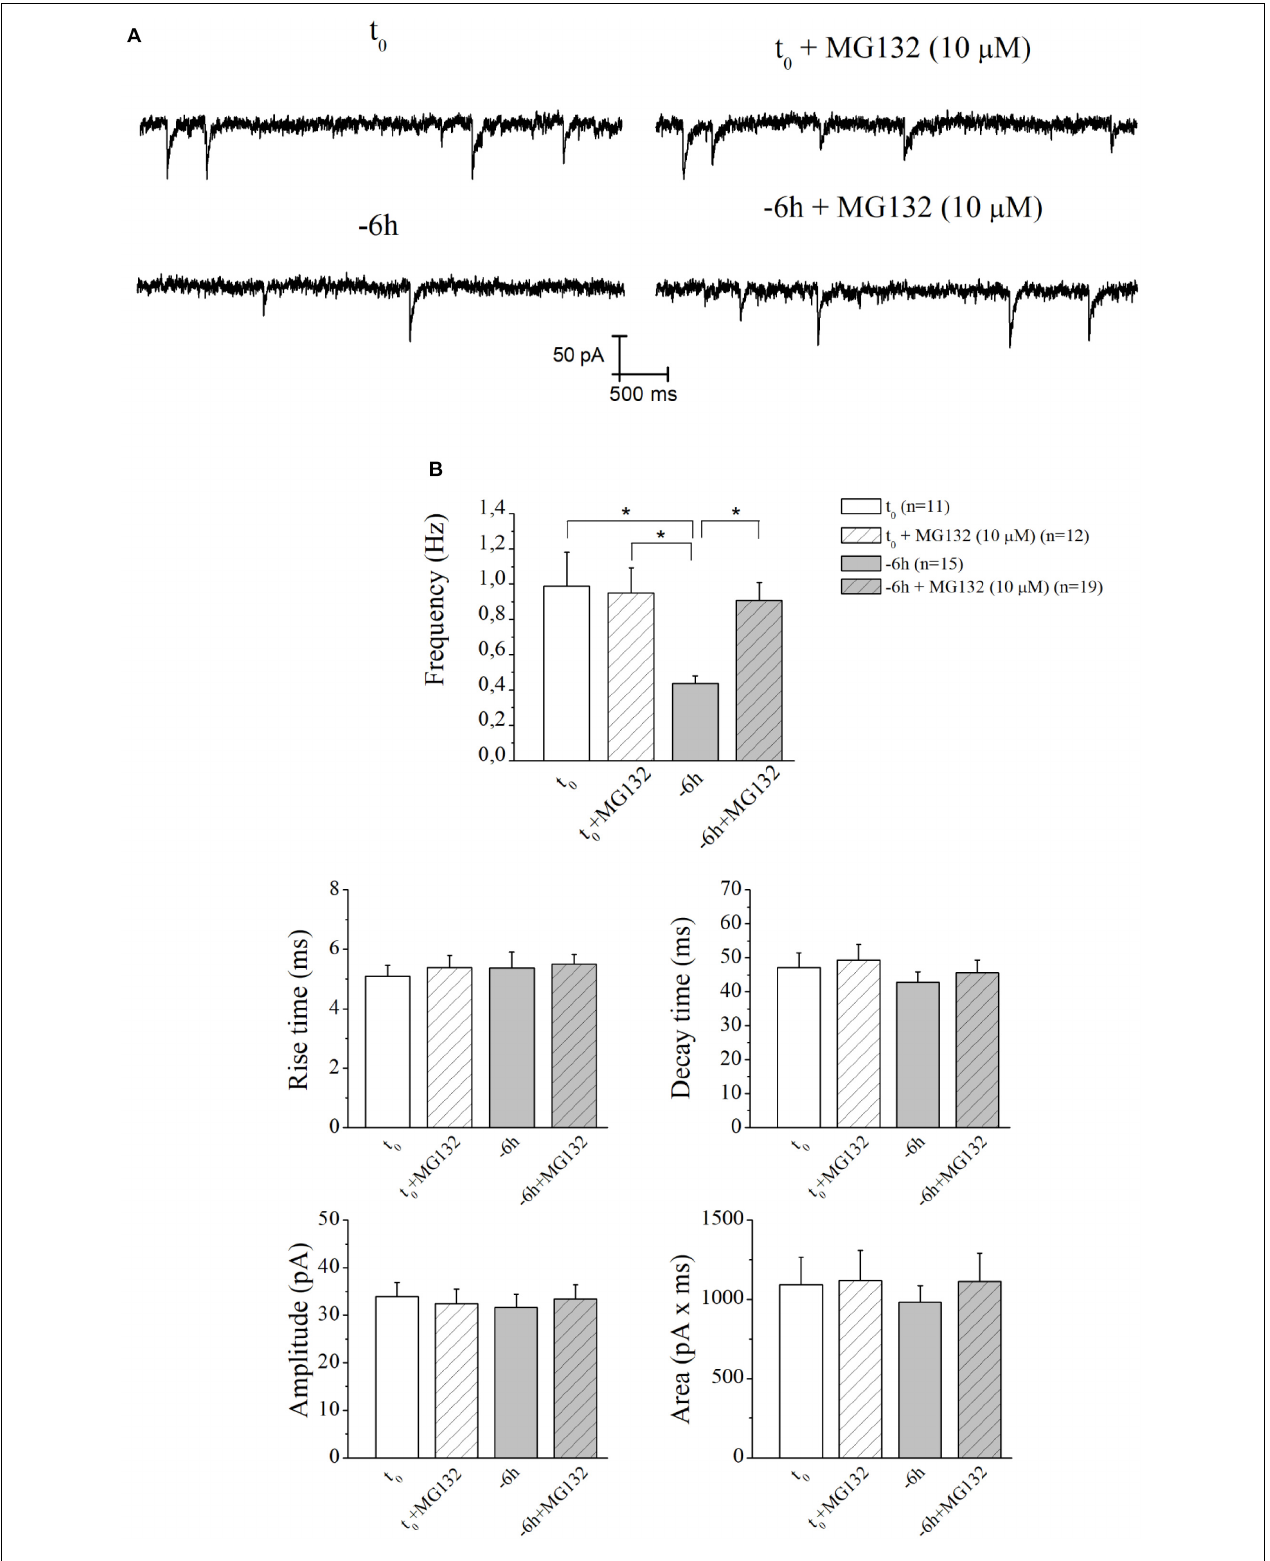
FIGURE 6 | UPS mediates the in vitro modulatory action of NGF on presynaptic function of cholinergic septo-hippocampal primary neurons. (A) Representative traces of septal neurons grown for 10–12 D.I.V. in B27 0.2%+NGF, deprived for 6 h of NGF, in the absence and presence of MG132 UPS-inhibitor (10 µ M) were